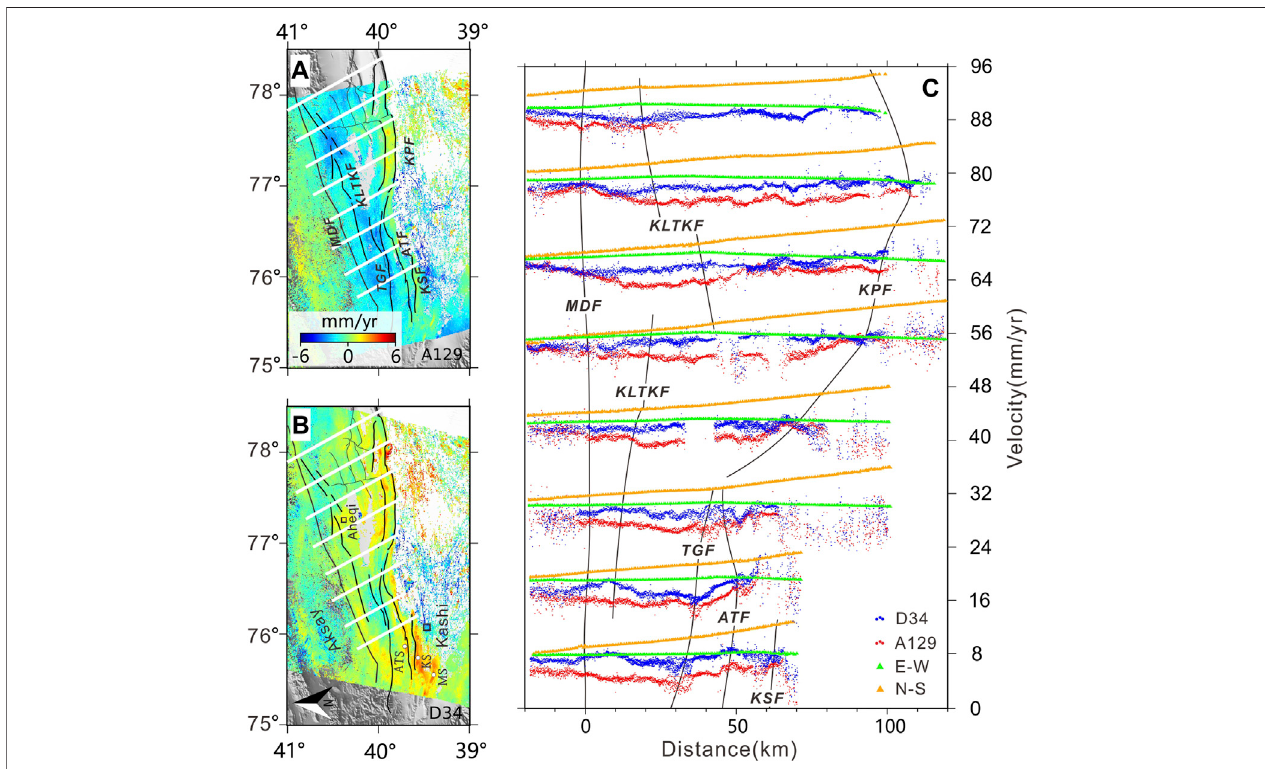
FIGURE 4 | Deformation data pro fi les across the south of southern Tianshan. (A) and (B) indicate LOS velocity map of the tracks 129 (A129) and 34 (D34),respectively. The white lines are 8 pro fi les locations (C) velocity pro fi le from D34 (blue dots), A129 (red dots), E-W (green triangle)and N-S (yellow triangle). The black lines are fault tracks. KSF: Kashi fault, ATF: Artux fault, TGF: Toth Goubaz fault, MDF: Maidan fault, KPF: Kepingtag fault, KLTKF: Kalatieke fault. MS: Mushi fold, KS: Kashi fold, ATS: Atushi